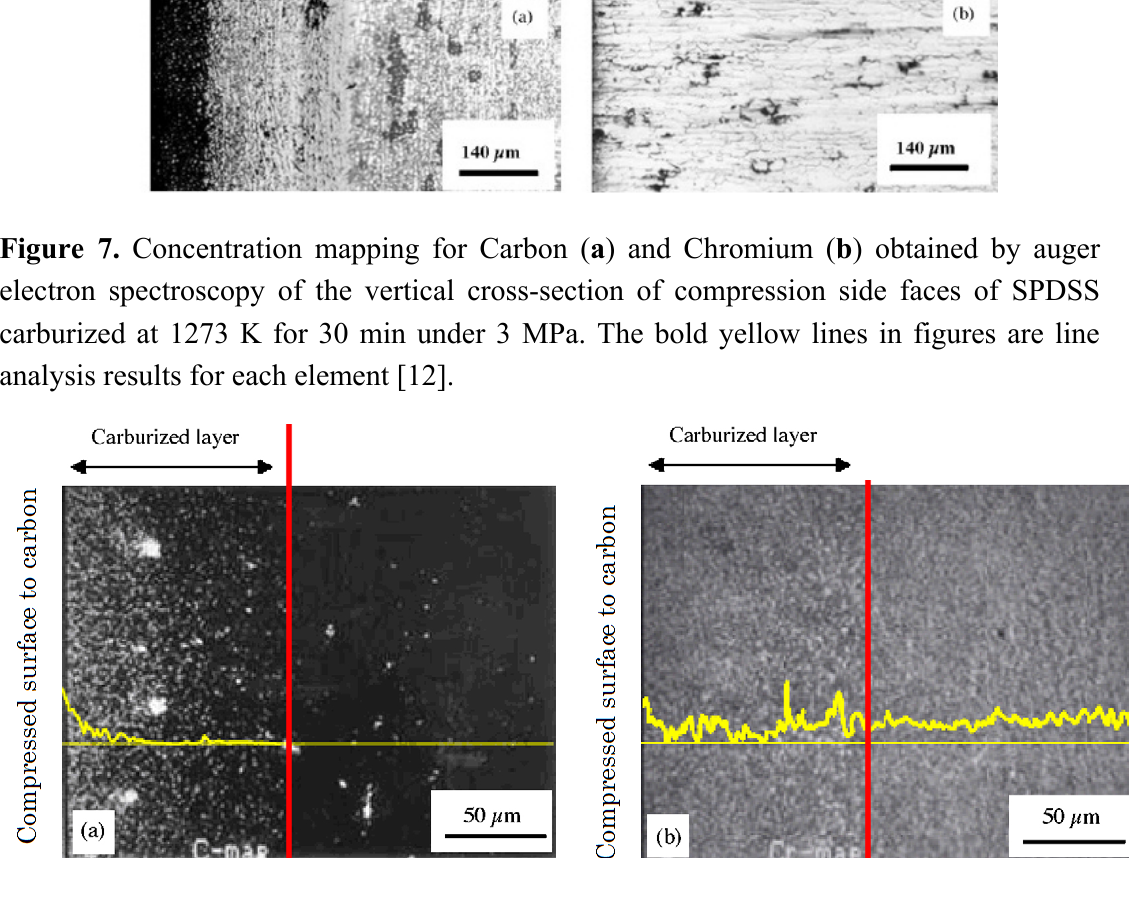
Figure 8. Micrograph of the vertical cross-section of compression faces of the SPDSS carburized at 1323 K ( a ) and 1223 K ( b ) for 30 min. The surfaces are electrolytically etched using a 10% oxalic acid